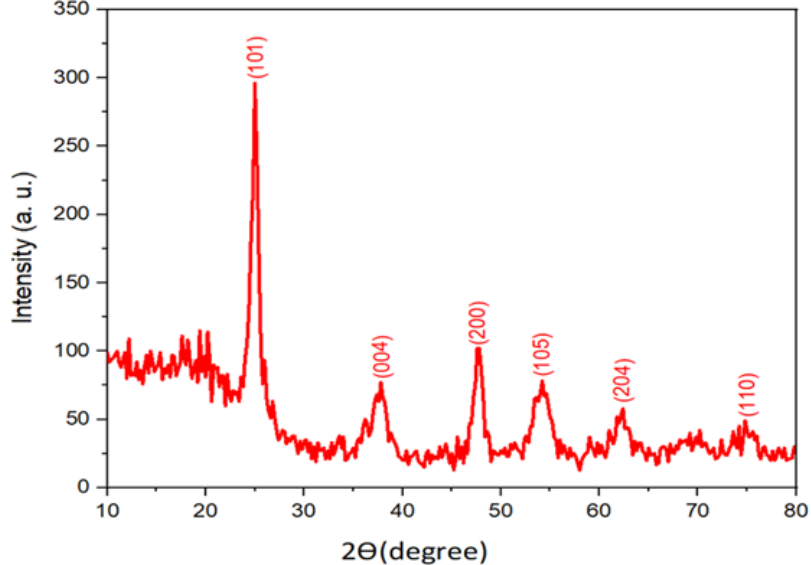
Figure 7. X-ray pattern of TiO 2 nanorods before heat treatment.